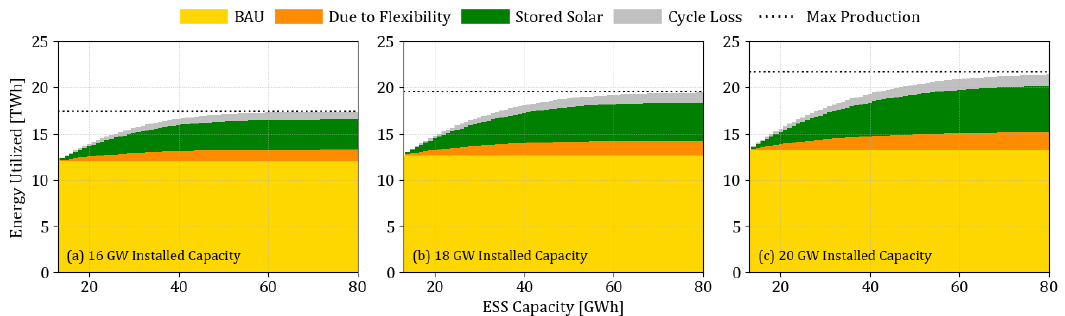
Figure 12. Changes in the total contribution of energy from the combined solar and ESS